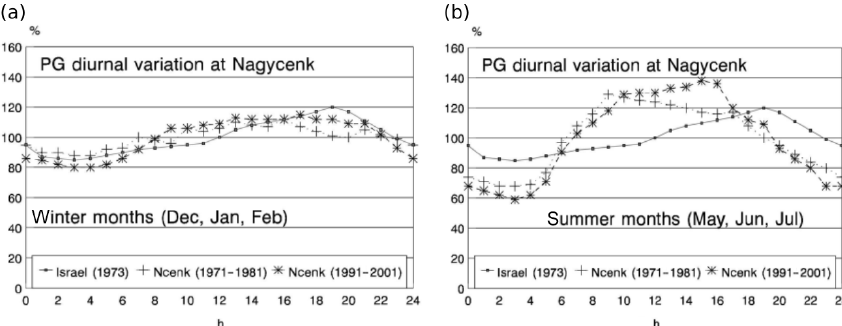
Figure 6. Diurnal variation of the PG for different PG datasets (PG over the oceans on undisturbed days as in Israel, 1973, and at NCK – abbreviated as Ncenk– in 1971–1981 and 1991–2001): (a) wintertime and (b) summertime PG values.